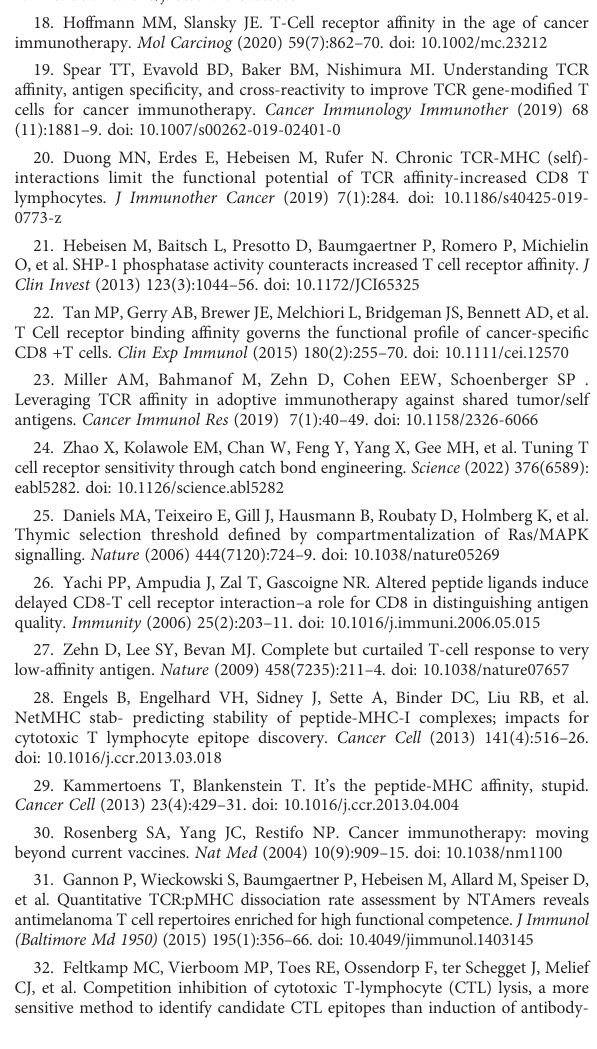
the cell-based blue peptide competition assay showing titration curves obtained for the different K i af fi nity peptide variants. The gMFI decrease along the competitor peptide concentration re fl ects the competition of the peptide variant with the “ blue ” -HBVc reference peptide, allowing to determine the half-maximal inhibitory concentration (IC 50 ) and the competition-derived af fi nity K i . ( D) Representative example of the cell- based blue peptide competition assay performed with distinct NY-ESO-1 peptide variants. SUPPLEMENTARY FIGURE 2 Correlation analysis between PRIME2.0 and peptide:HLA af fi nity (A) Correlation between PRIME2.0 and binding assay refolding OD indexes. Melan-A 26-35 (left graph) and NY-ESO-1 157-165 (right graph) peptide variants are shown with the respective native and analog peptides highlighted in blue and red. R square and p values were obtained from